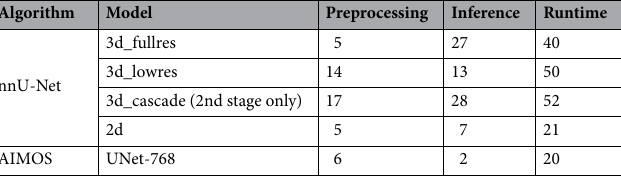
Table 4. Comparison of the average preprocessing and inference times, and total runtimes in